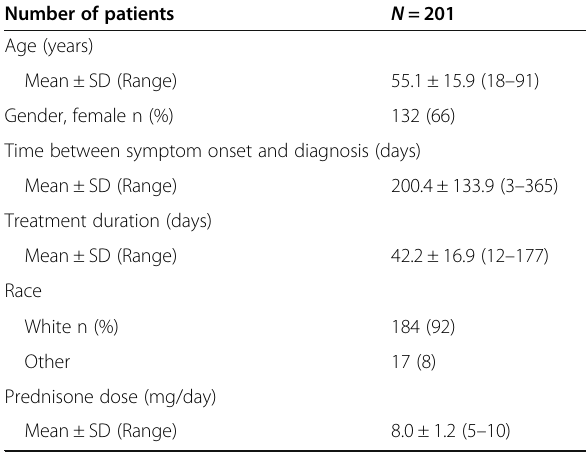
Table 1 Characteristics of patients newly diagnosed with rheumatoid arthritis